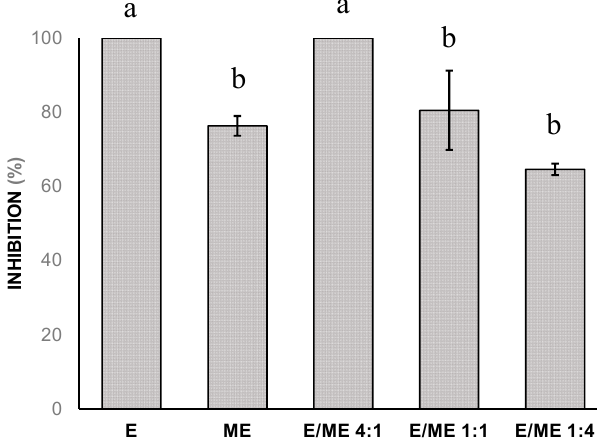
Figure 1. The antifungal index (%) of eugenol (E) and methyleugenol (ME) individually, and in combined effects of the proportions 4:1, 1:1 and 1:4, at concentration of 0.75 mg/mL, against F. solani f. sp. piperis . a, b Values with the same letter are not statistically different at the p < 0.05 level (Tukey’s